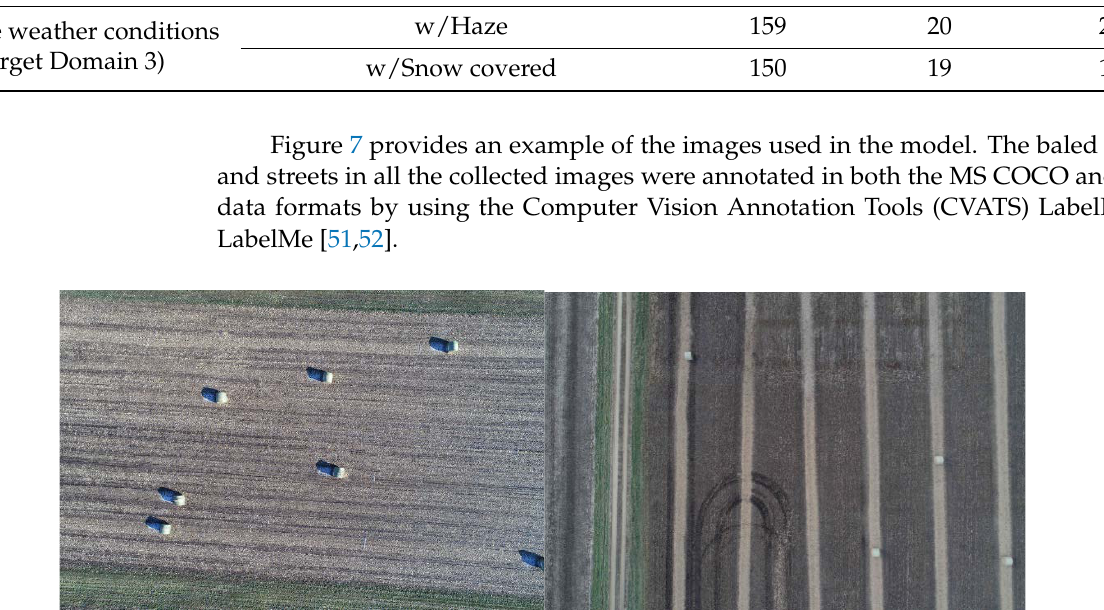
Figure 7. Example of the drone-collected images under good lighting conditions in the fall (the initial condition).